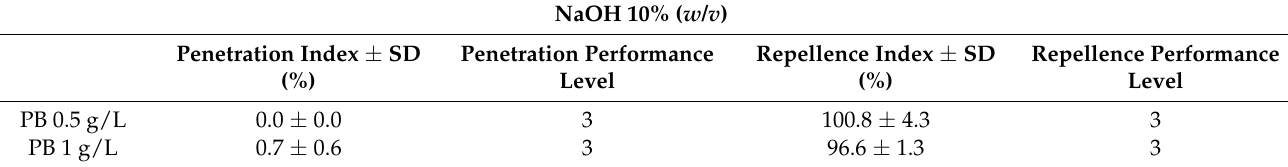
Table 5. Values of penetration index (%) and repellency index (%) for polyester knits function- alised with Prussian blue (PB) at 0.5 and 1 g/L, after contact with NaOH 10% ( w / v ), (n = 3, ± SD). Performance levels were attributed to penetration and repellence indexes according to ISO